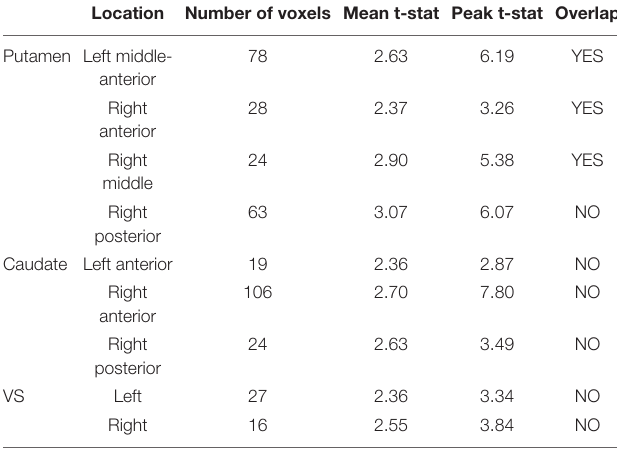
TABLE 1 | Group-level significant [11C]Raclopride displacement clusters. Location Number of voxels Mean t-stat Peak t-stat